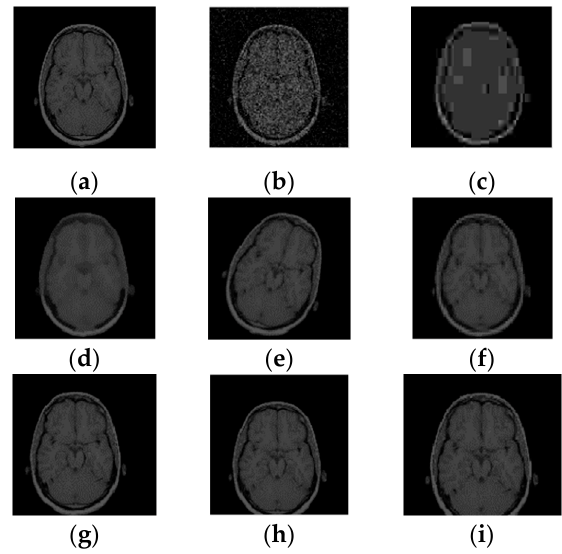
Figure 7. Different attacks on the brain: ( a ) Original image; ( b ) Gaussian noise (1%); ( c ) JPEG compression (4%); ( d ) Median filter [3 x 3] (10 times); ( e ) Rotation (clockwise, 20°); ( f ) Scaling (×0.5); ( g ) Translation (5%, left); ( h ) Translation (7%, down); ( i ) Cropping (10%, Y direction).